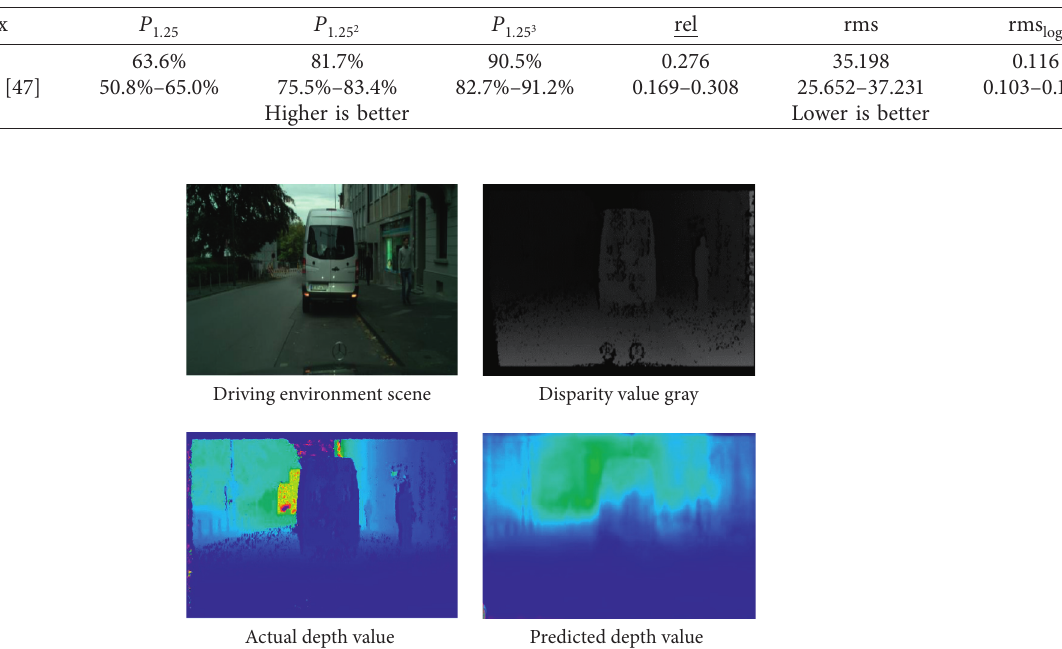
Figure 10: Prediction results of depth estimation. (a) Driving environment scene. (b) Disparity gray value. (c) Actual depth value. (d) Predicted depth value.